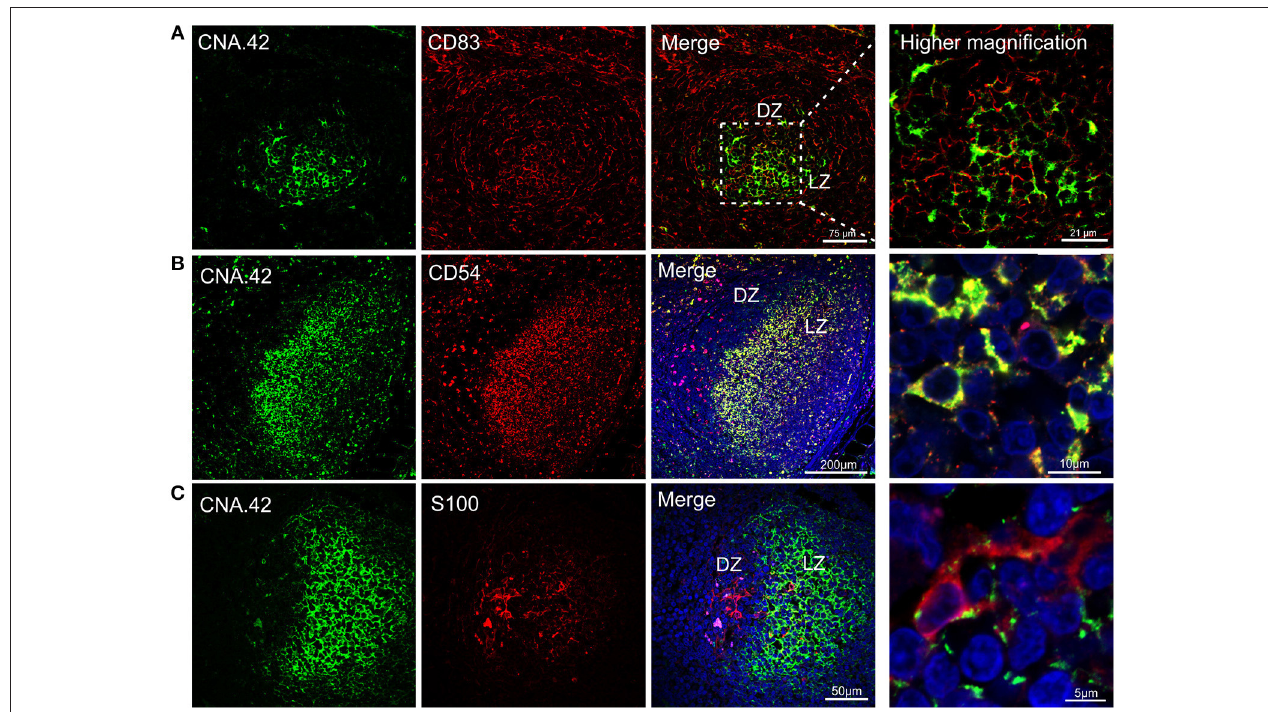
FIGURE 5 | Immunophenotyping of sheep follicular dendritic cells. Representative confocal micrographs of sheep lymph node sections. (A) Sections were stained for CD83 (red) and CNA.42 (green). CD83 identified dark zone reticular cells present in the follicle. CNA.42 was expressed only by FDC in the light zone of the follicle. The use of CD83 and CNA.42 allow identifying a dark (DZ) and a light zone (LZ) in the follicles. Note the expression of both markers in cells present at the border between dark and light zone. (B) Sections stained for CD54 (red) and CNA.42 (green). CD54 and CNA.42 are both markers for light zone FDC. (C) Sections stained for S100 (red) and CNA.42 (green), S100 labels FDC in the dark zone. Nuclei are stained in blue (DAPI).